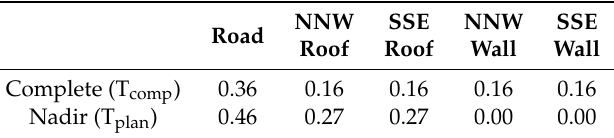
Table 2. Weights applied to individual wall, roof, and road surface temperature components in order to calculate complete and nadir temperatures for the Basel Sperrstrasse street